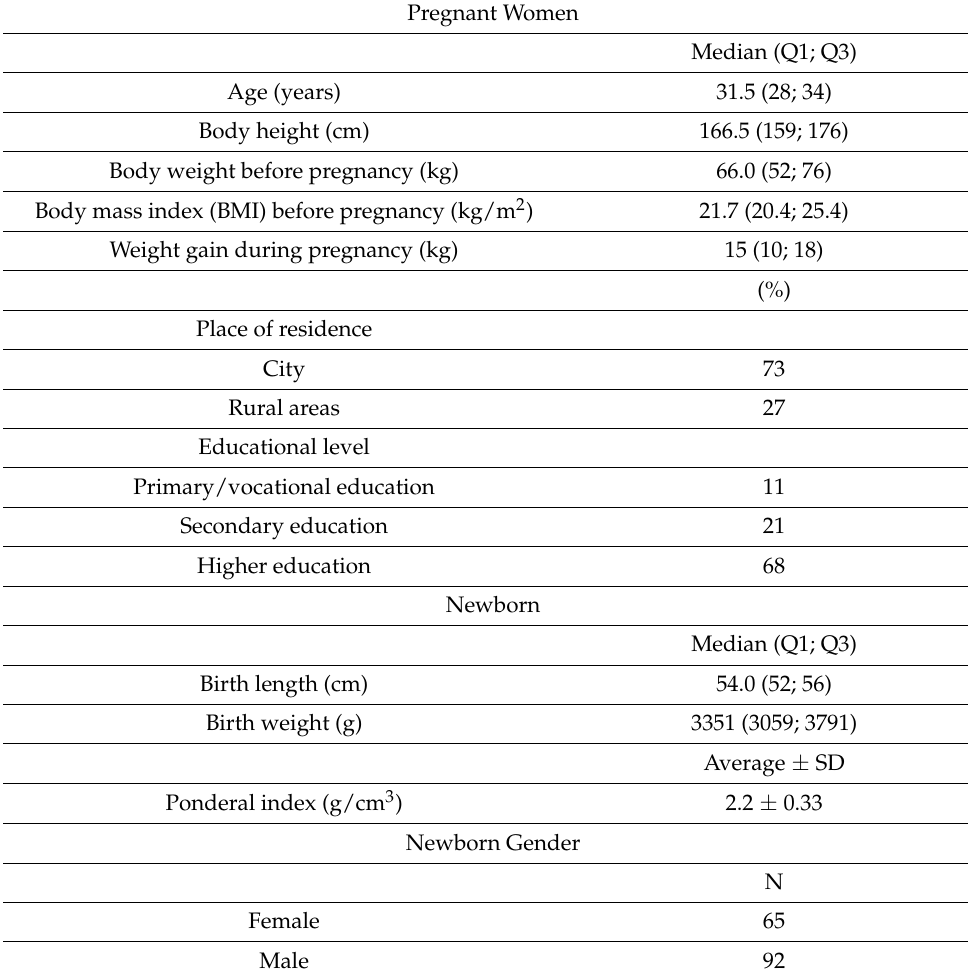
Table 1. Basic characteristics of participants: women and newborns ( n =